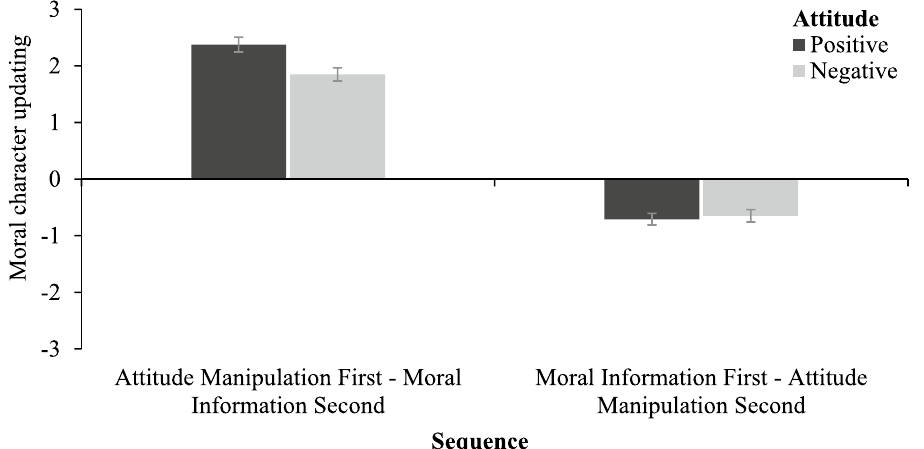
Figure 4. Mean index of updating impressions of moral character as a function of the sequence and attitude manipulation. Higher scores in the positive or negative direction indicate a greater impression change. The error bars represent one standard error.